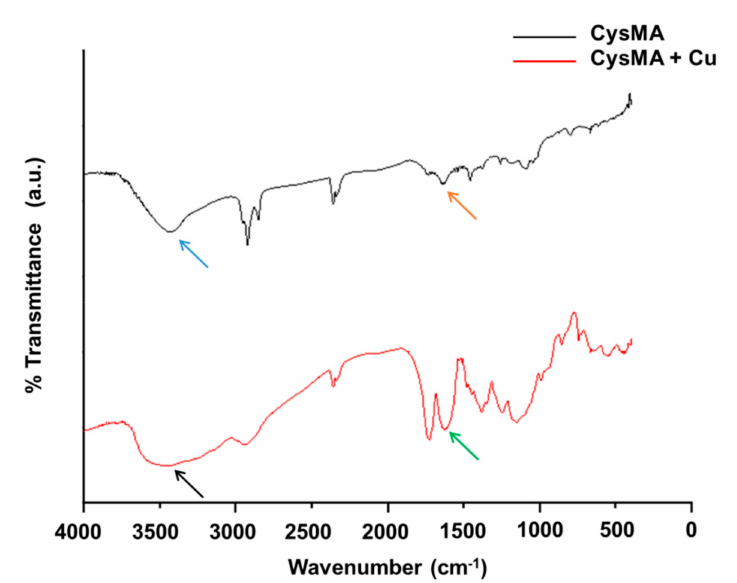
Figure 5. FTIR analysis. Two functional groups of hydrogels; COO- shifted from 1635 cm − 1 (orange arrow) to 1626 cm − 1 (green arrow), and that of NH 3 + , located at 3300–3500 (blue and black arrow), showed that hydrogels were chelated with copper ions; a.u. = arbitrary unit.